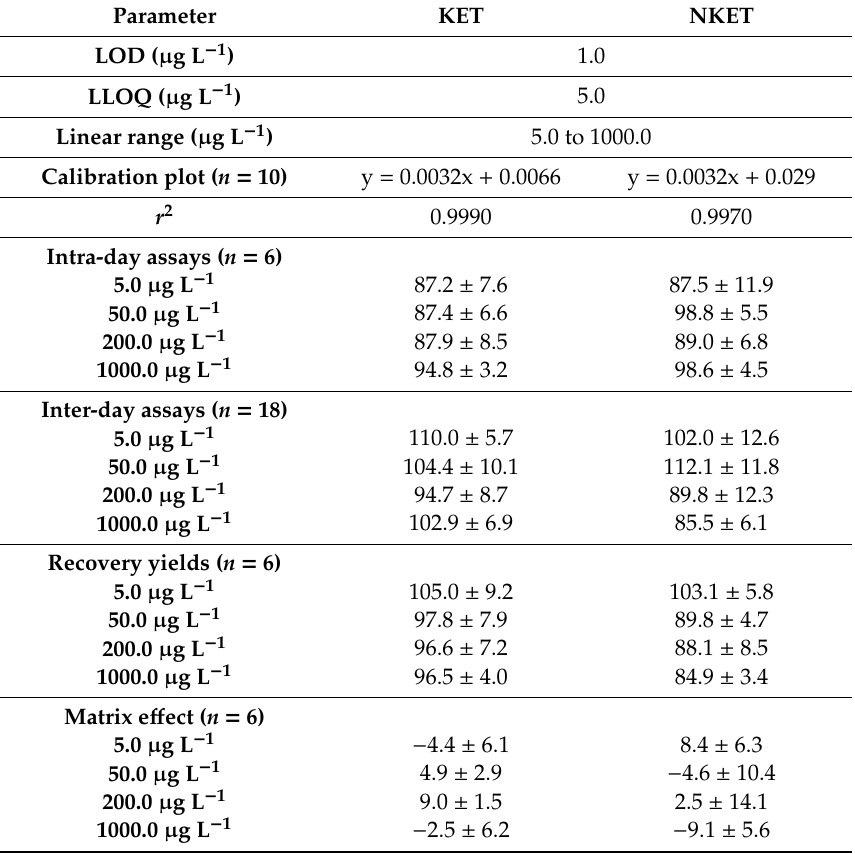
Table 2. Intraday ( n = 6) and interday ( n = 18) accuracy (%) and precision ( ± relative standard deviation (RSD), %), recovery yields (% ± RSD, %) and matrix e ff ects (% ± RSD, %) using four spiking levels, as well as limits of detection (LODs), lower limits of quantification (LLOQs), linear ranges and r 2 , for KET and NKET in urine matrices, obtained by BA µ E- µ LD / LVI-GC-MS(SIM), under optimized experimental conditions.